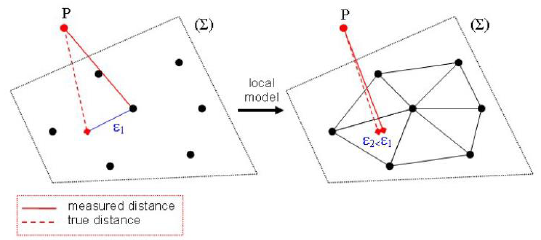
Figure 6. The concept of local surface model C2C distance computation method